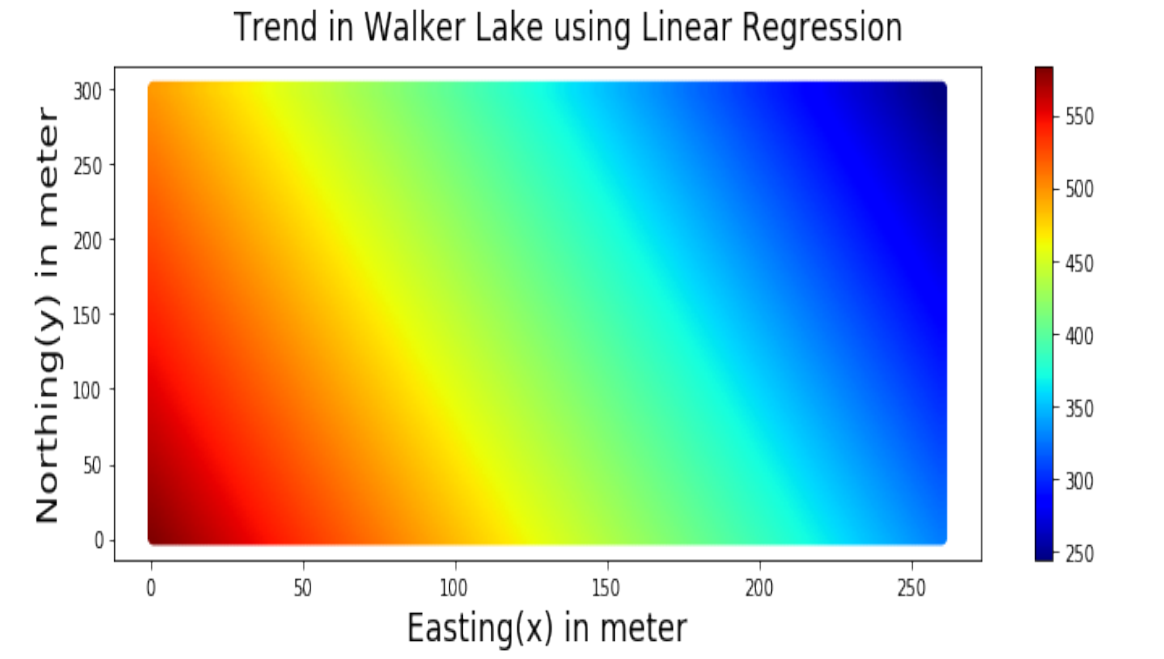
Figure 6. Trend of the V variable of Walker Lake dataset represented by Equation (9).